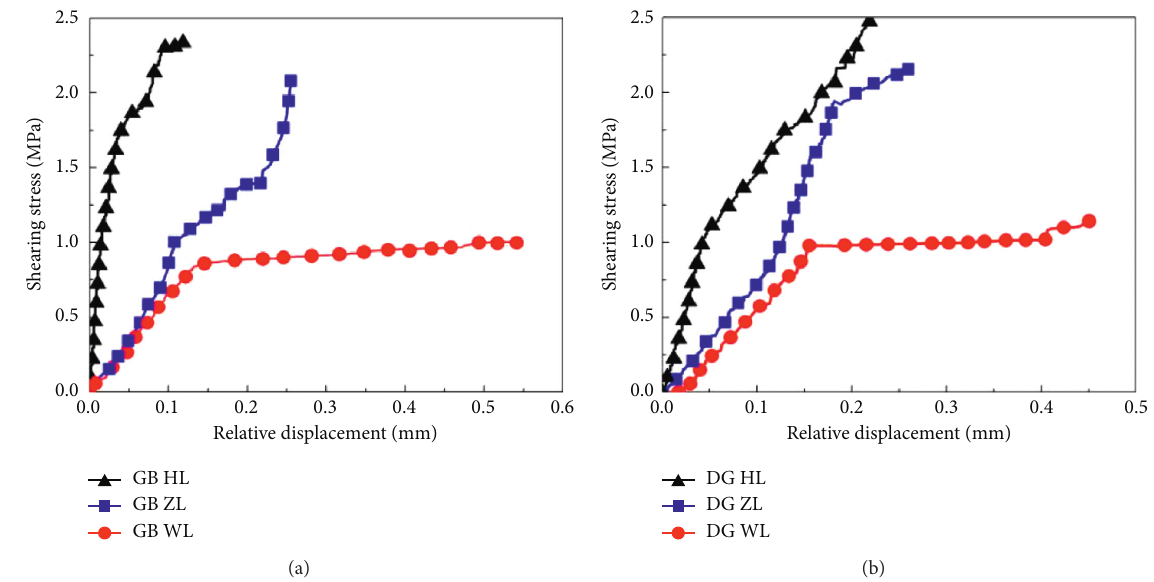
Figure 10: Relationship of the shearing stress over the relative displacement of the interface for composite samples with different ribs: (a) GB and (b) DG. Table 11: Maximum strain of the interface at failure for composite samples with different ribs. Cement